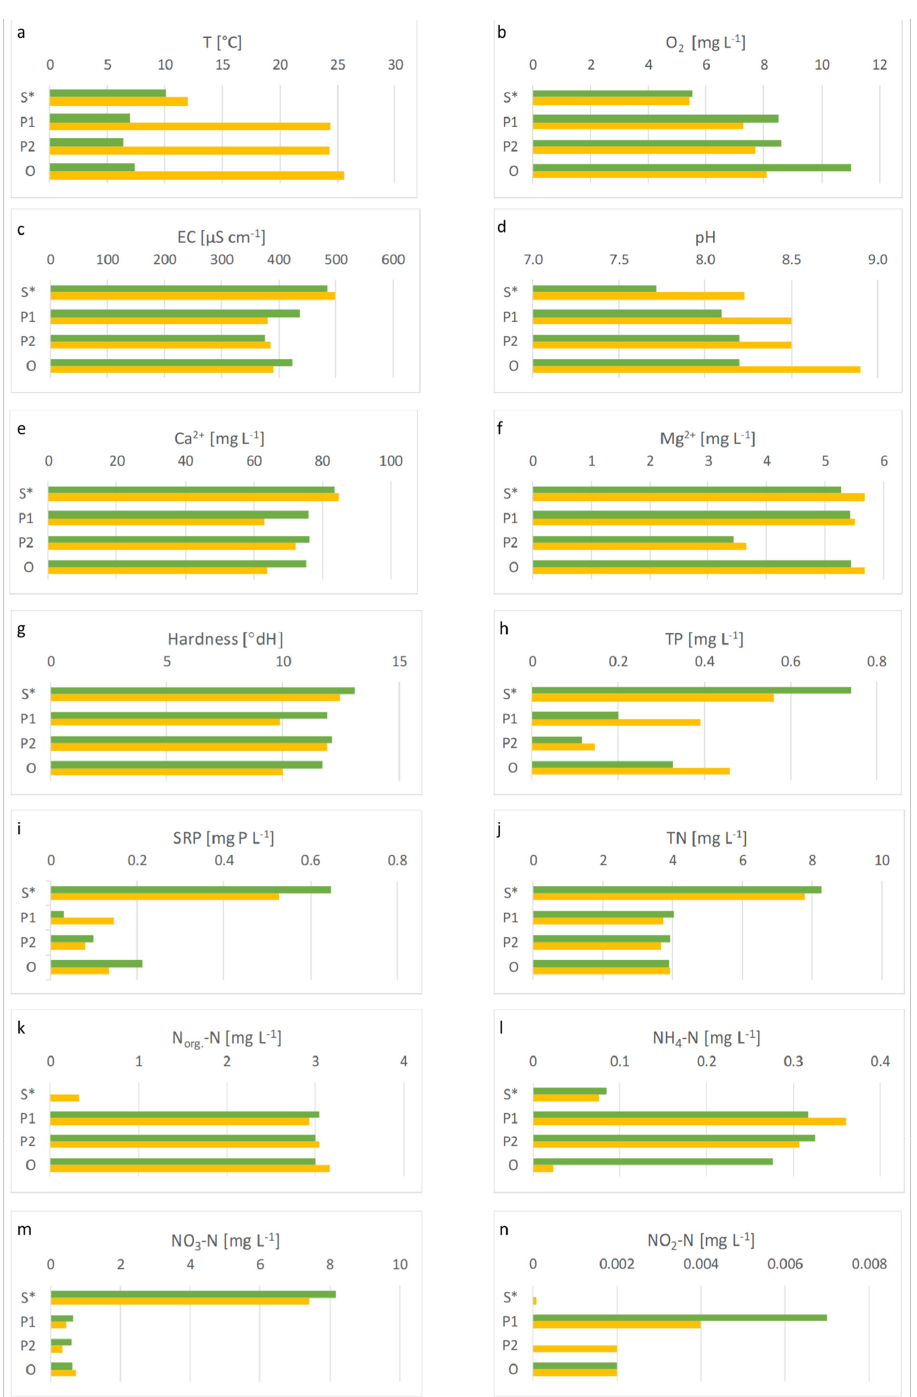
Figure 6. Di ff erentiation of water properties between the studied sites. P1—pelagial 1, P2—pelagial 2, O—outflow, S—spring, * — mean values for all springs. Green bars—April, yellow